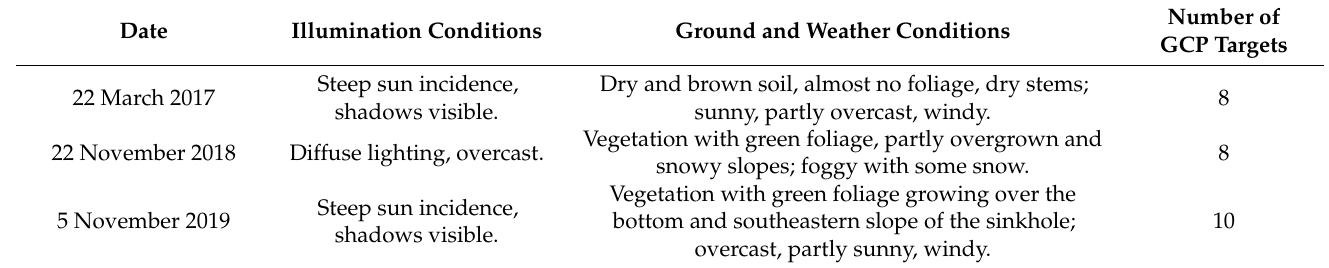
Table 1. Survey characteristics including the number of ground control points